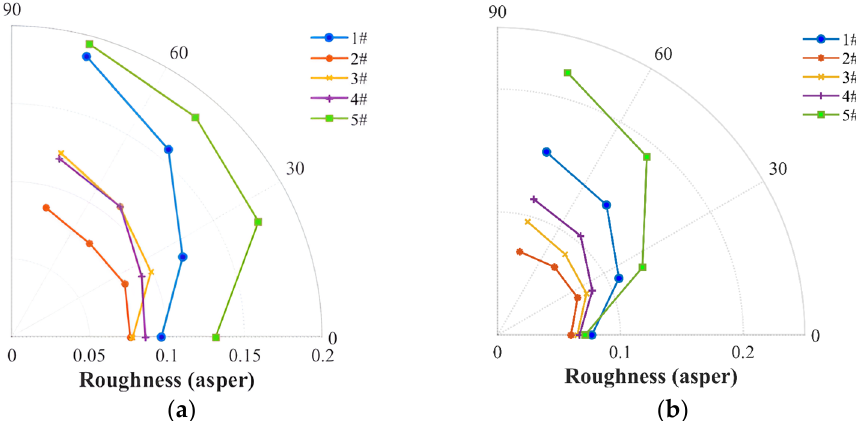
Figure 15. Comparison of noise roughness among the two-blade propeller (#1), four-blade propeller (#2), loop-type propeller (#3), wide chord loop-type propeller (#4), and DJI Phantom III propeller (#5) at a rotational speed of 5400 rpm ( a ) and at a stable thrust of 3 N ( b ).